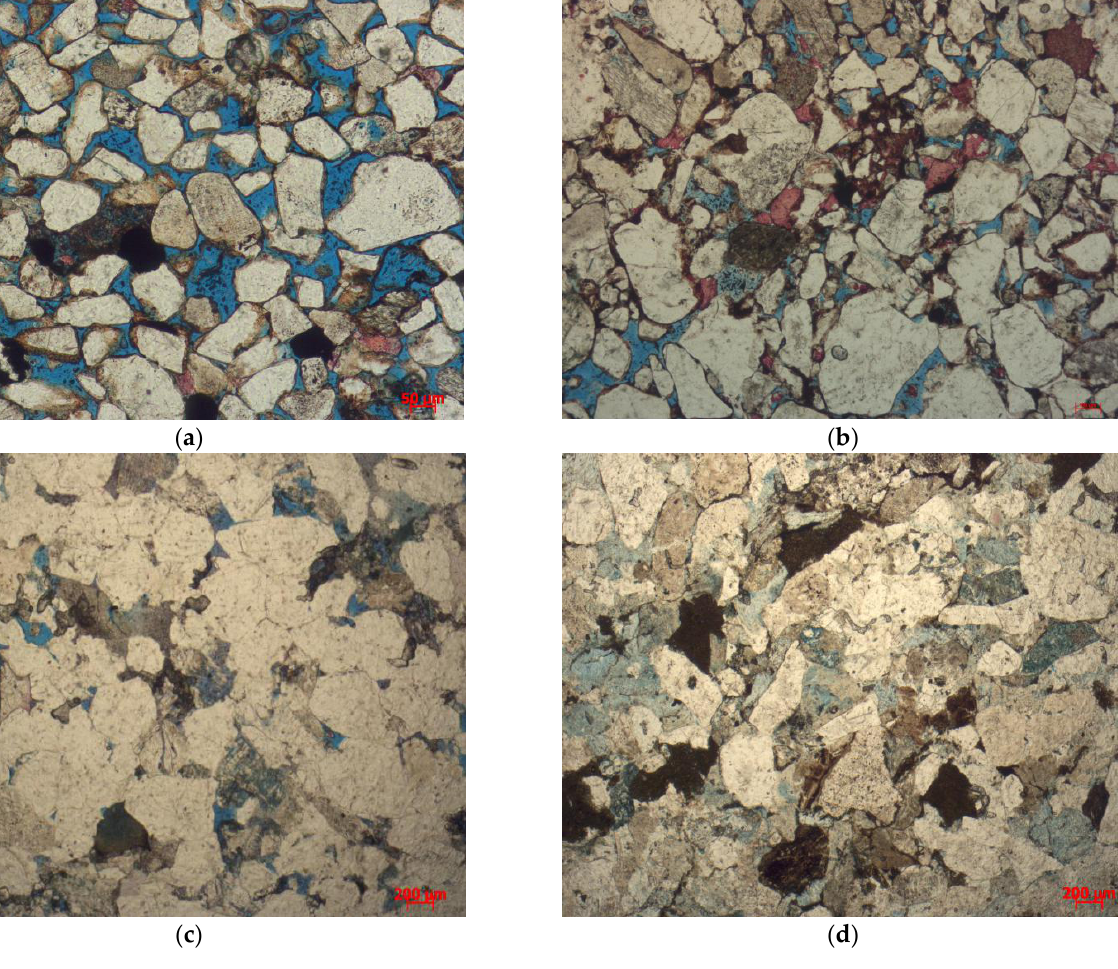
Figure 10. Comparisons of pores, pore throats and pore connectivities among the four subcategories of sandstone in casting thin slices under a polarizing microscope (note that the deep blue colors are mostly intergranular pores, the light blue colors are mostly intragranular pores and micropores). ( a ) Subcategory I 1 sandstone (Z23). ( b ) Subcategory I 2 sandstone (Z11). ( c ) Subcategory II 1 sandstone (X9). ( d ) Subcategory II 2 sandstone (T13).